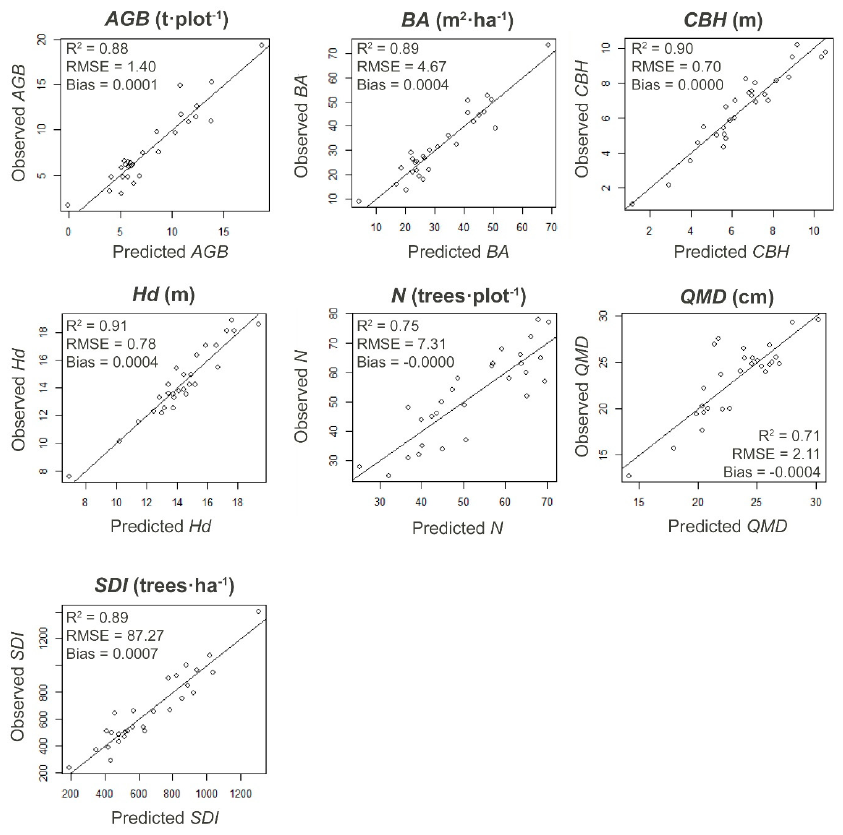
Figure 8. Scatterplot of predicted vs. observed values of the seven forest parameters ( AGB , BA , CBH , Hd , N , QMD, and SDI ) using the selected multiple linear regression models.